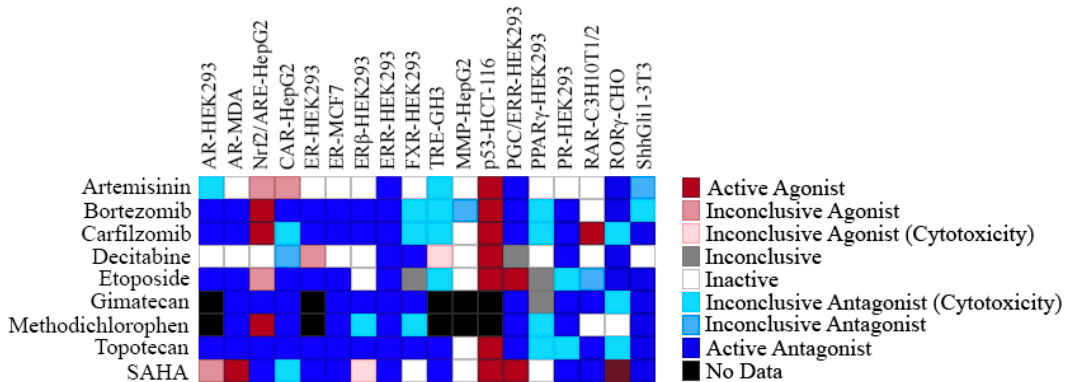
Figure 3. Assay heatmap of anticancer ERR α antagonists. The nine potential ERR α antagonist antineoplastic agents were screened, and their activity outcome in 15 antagonist assays (AR-HEK293, AR-MDA, CAR-HepG2, ER-HEK293, ER-MCF7, ER β -HEK293, ERR-HEK293, FXR-HEK293, TRE-GH3, PGC/ERR-HEK293, PPAR γ -HEK293, PR-HEK293, RAR-C3H10T1/2, ROR γ -CHO, ShhGli1-3T3), 2 agonist assays (Nrf2/ARE-HepG2 and p53-HCT-116), and the MMP-HepG2 assay is displayed.